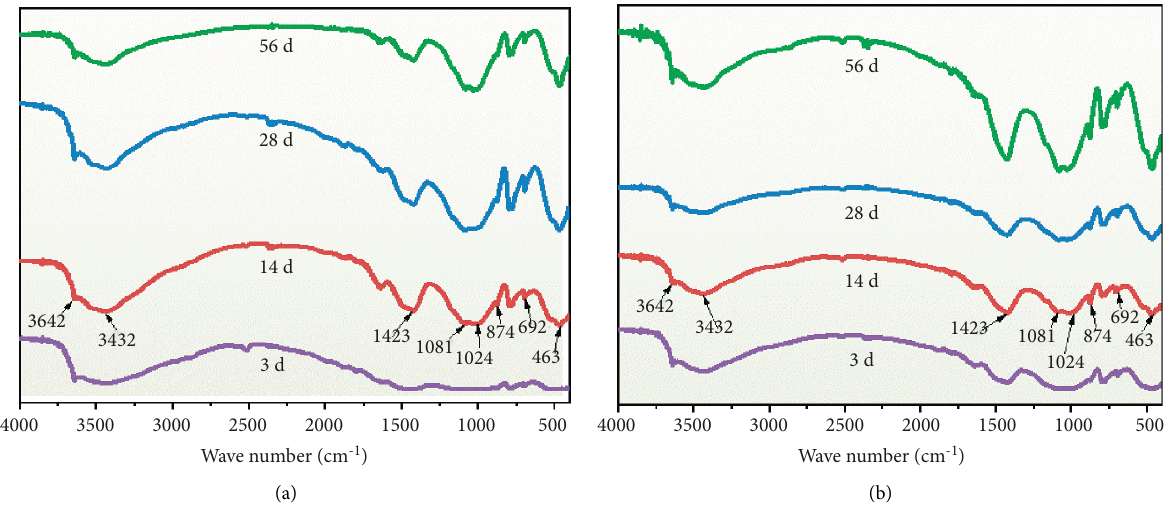
Figure 10: FTIR spectra of different ages: (a) S-Non; (b) S-100-0.200%.